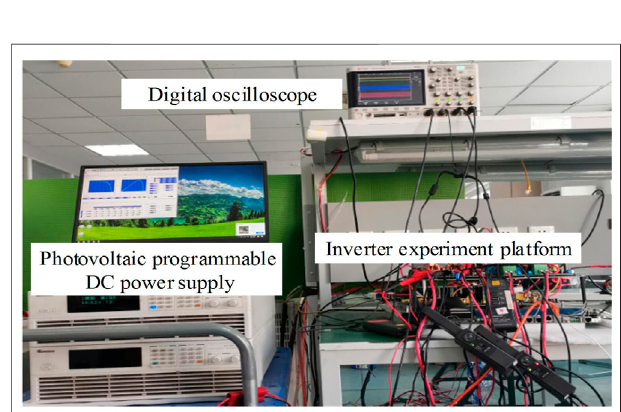
FIGURE 11 | Prototype of the experimental